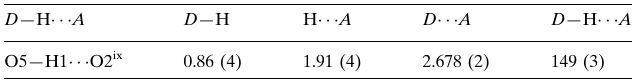
Hydrogen-bond geometry (A˚ , (cid:4)